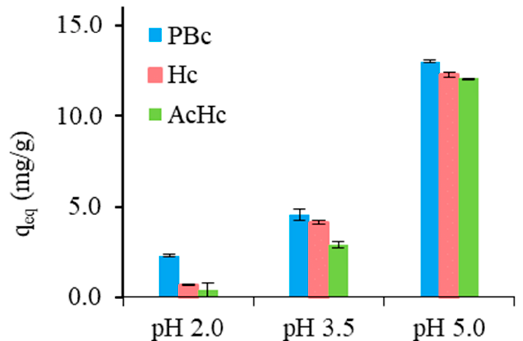
Figure 6. Effect of pH on Pb(II) adsorption ( ± global uncertainty), C 0 = 20 mg/L Pb(II), C s = 0.5 g/L sorbent, T = 23 ± 1 °C, 4 h contact time.